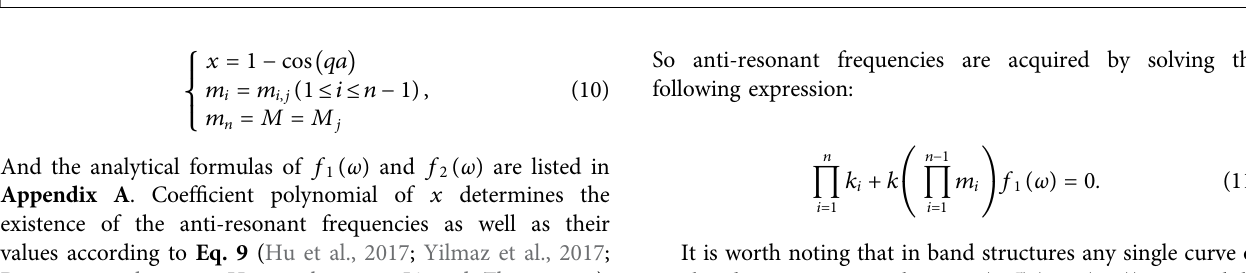
Frontiers in Materials |